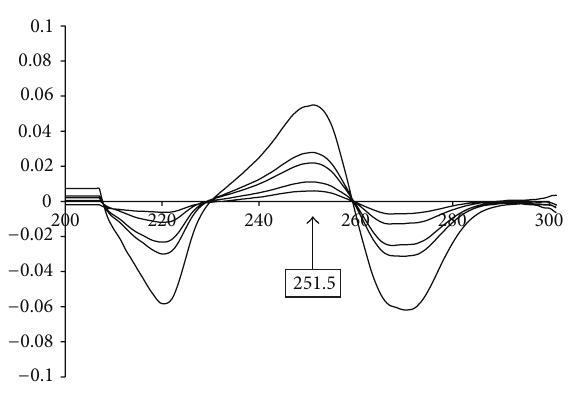
Figure 4: First derivative of ratio spectra of 2, 4, 8, 10, and 20 𝜇 gmL −1 TEN using 20 𝜇 gmL −1 EMT as